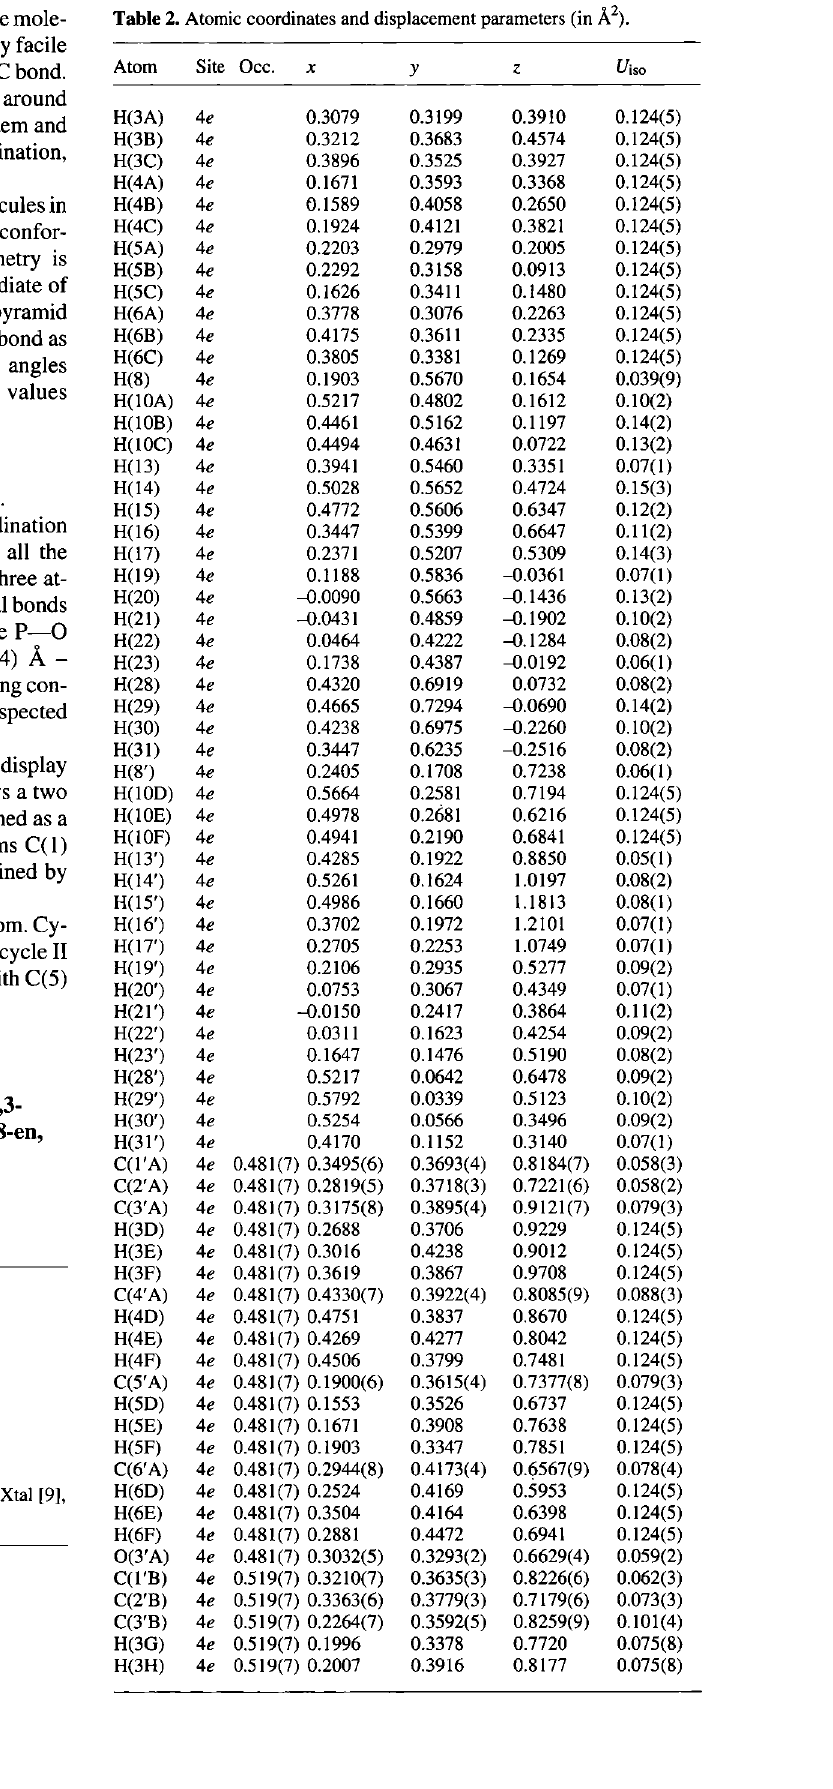
Table 2. Atomic coordinates and displacement parameters (in A 2